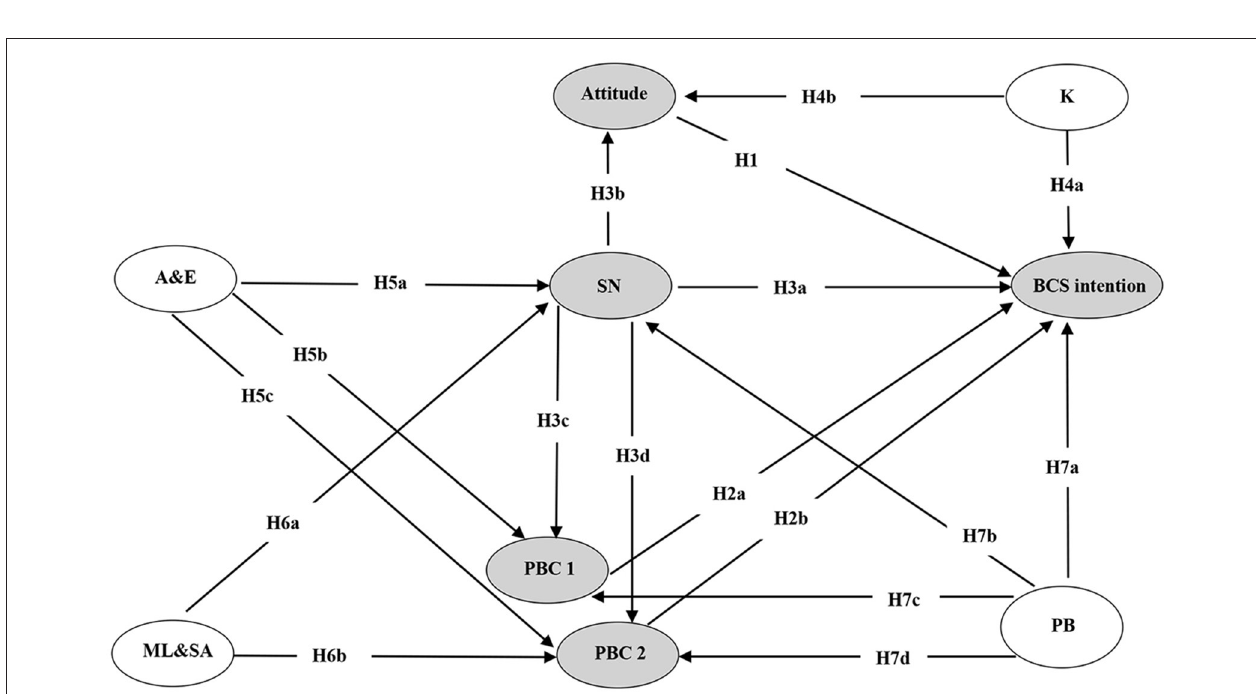
FIGURE 2 | The research hypotheses and research model. SN, subjective norm; PBC 1, perceived behavioral control 1; PBC 2, perceived behavioral control 2; BCS intention, breast cancer screening intention; K, knowledge; PB, past behavior; A&E, advocacy and education; ML&SA, the medical level and service attitude. K,